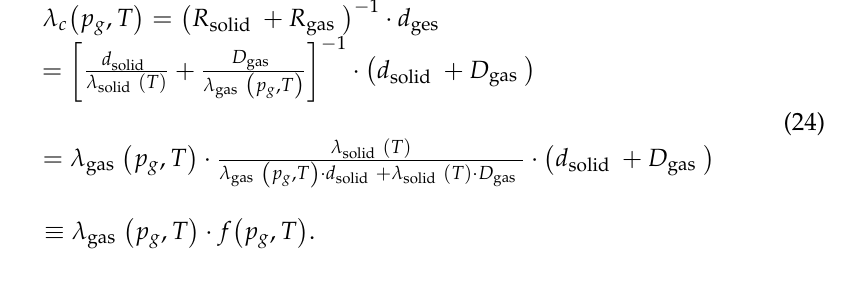
Figure 11. Gas-solid coupling thermal conductivity model established by Bi et al. [53] (h represents length of heat flux path in the solid phase).